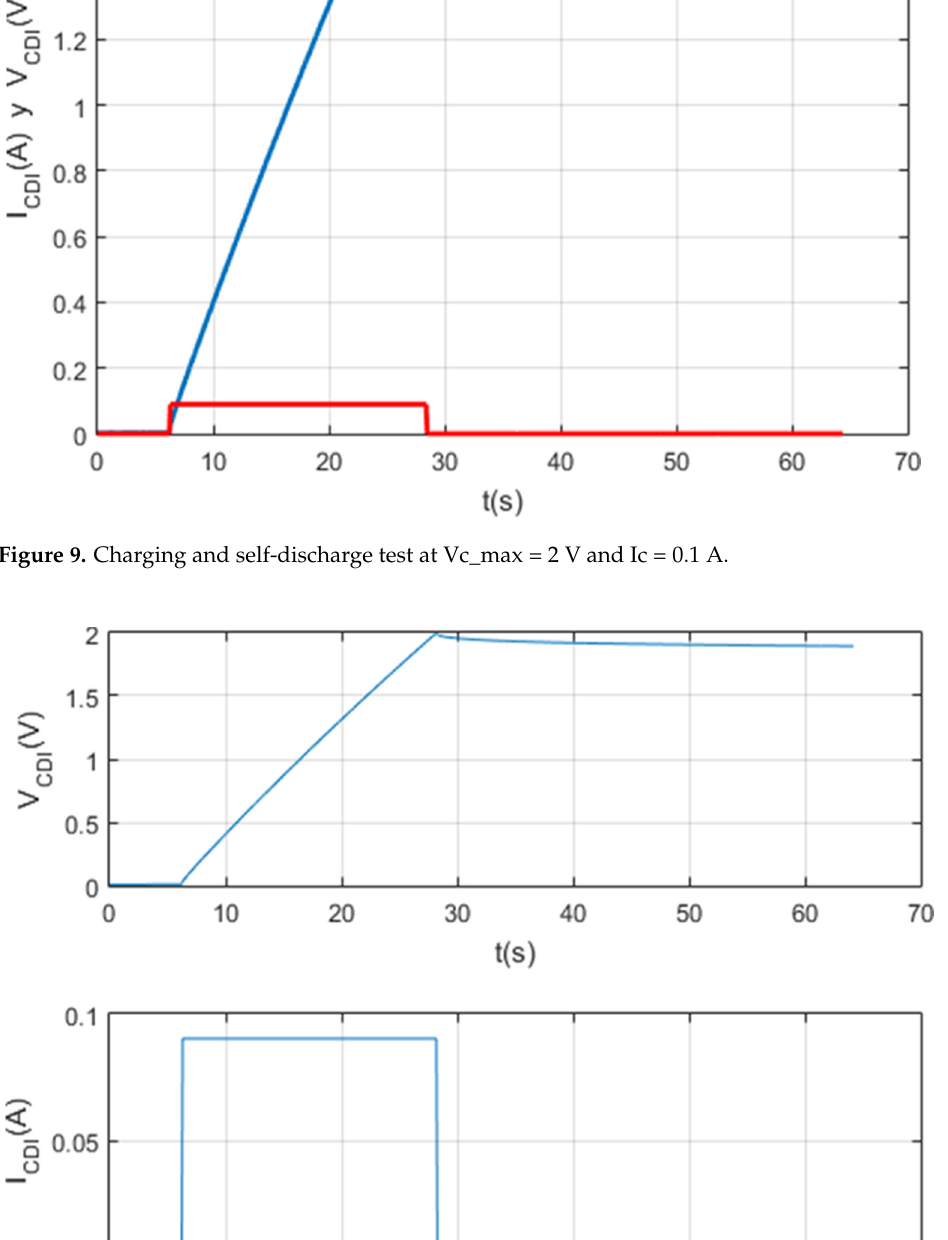
Figure 11. Load and self-discharge test at Vc_max = 2 V and Ic = 0.05 A.